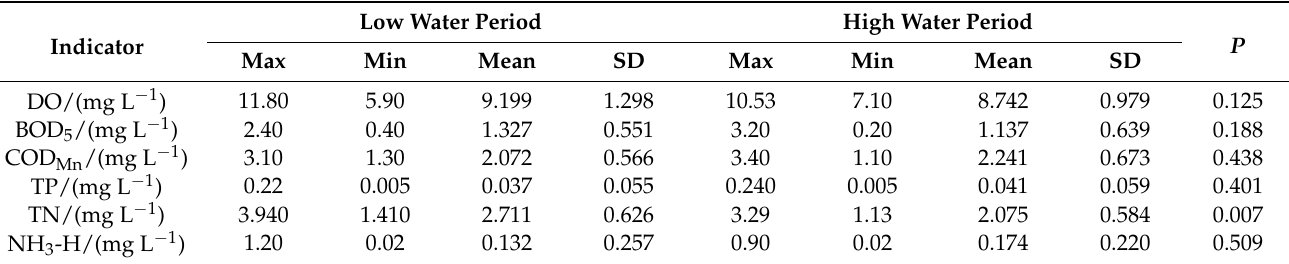
Table 5. Statistical description of the Taigou